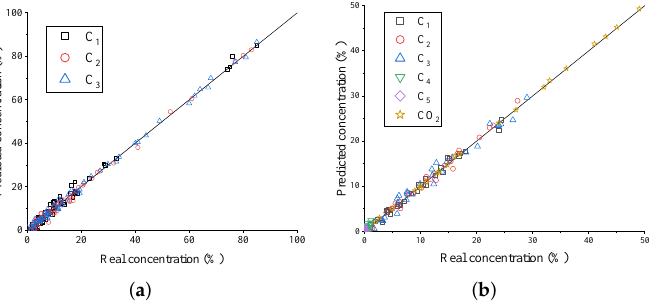
Figure 12. Prediction results in three-component dataset and six-component. ( a ) Prediction of the three-component dataset. ( b ) Prediction of the six-component